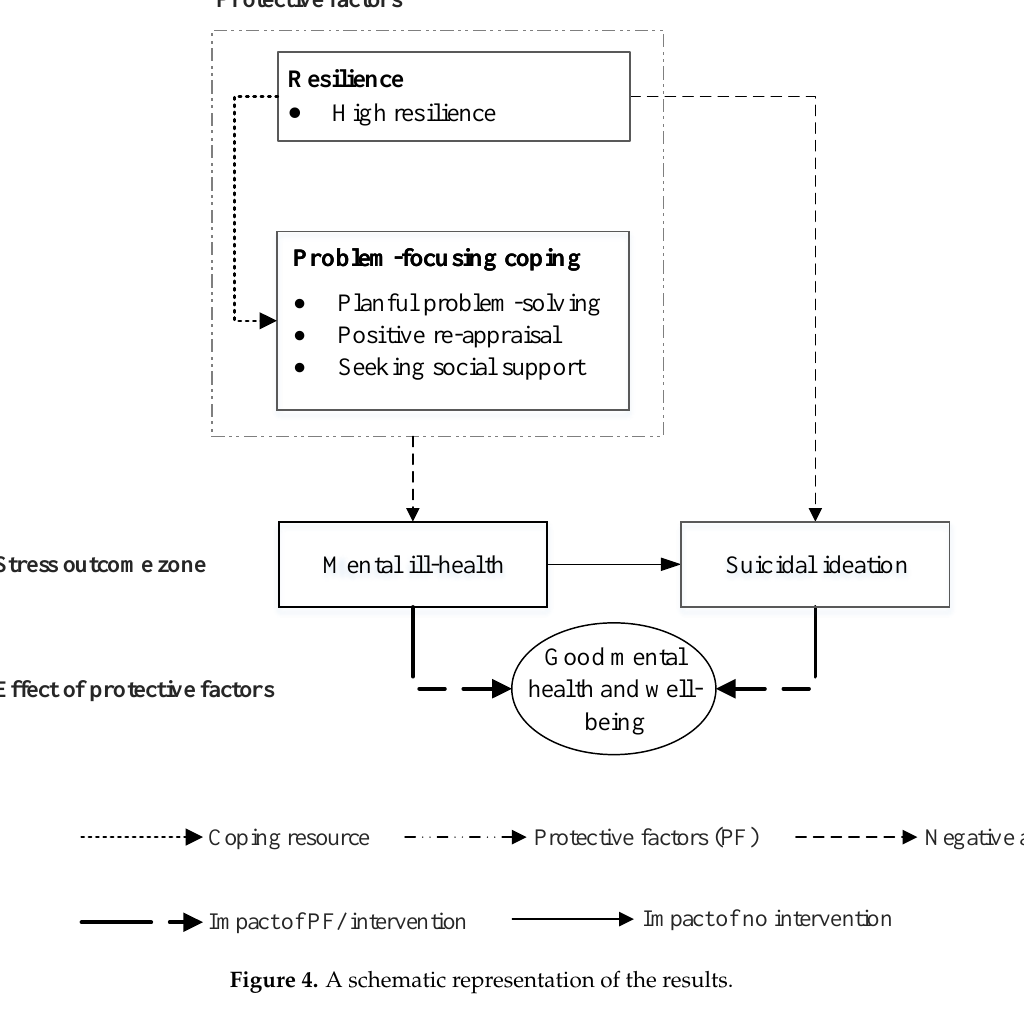
Figure 4. A schematic representation of the results.